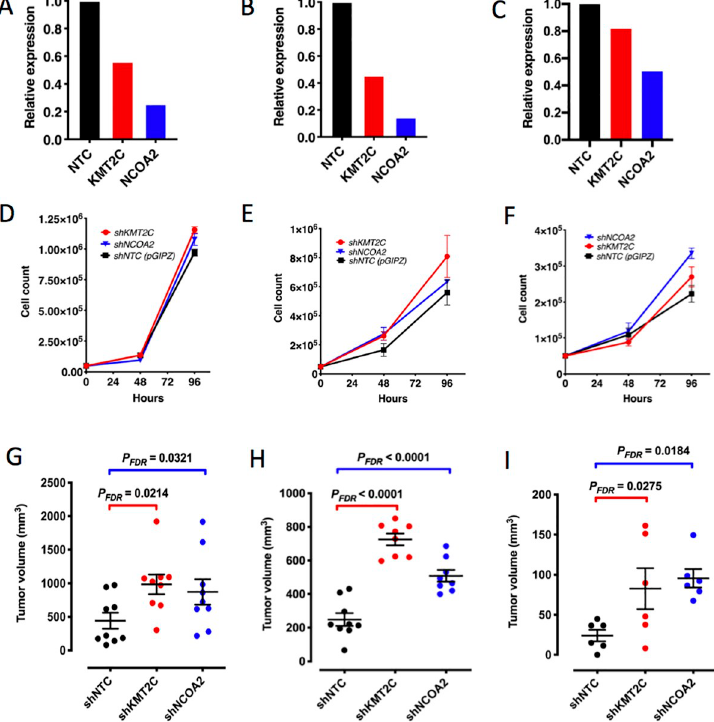
Fig 9. In vitro and in vivo functional validation of chromatin remodelers in cuSCC. Levels of shRNA-mediated knockdown of KMT2C or NCOA2 in human cuSCC cell lines ( A ) A431 ( B ) COLO16 or ( C ) SCC13 cells confirmed by qPCR compared to a non-targeting (NTC) shRNA. Target gene knockdown significantly increases proliferation rates of ( D ) A431 (shNTC vs. sh KMT2C q -value < 0.0001; shNTC vs. sh NCOA2 q -value = 0.0019; sh KMT2C vs. sh NCOA2 q = 0.017), ( E ) COLO16 (shNTC vs. sh KMT2C q -value = 0.01; shNTC vs. sh NCOA2 q-value = 0.4; shKMT2C vs. shNCOA2 q = 0.06) or ( F ) SCC13 cells (shNTC vs. shKMT2C q -value = 0.06; shNTC vs. shNCOA2 q -value < 0.0001; shKMT2C vs. shNCOA2 q = 0.01); 3 replicates per group; error bars, SEM; statistical significance measured by two- factor ANOVA followed by FDR-corrected q- values for multiple comparisons. KMT2C and NCOA2 knockdown significantly accelerates cuSCC xenograft progression in vivo . ( G ) A431, corrected P = 0.0488 (shNTC vs. sh KMT2C P FDR = 0.0214; shNTC vs. sh NCOA2 P FDR = 0.0321), ( H ) COLO16, corrected P < 0.0001 (shNTC vs. sh KMT2C P FDR < 0.0001; shNTC vs. sh NCOA2 P FDR < 0.0001) and ( i ) SCC13, corrected P = 0.0198 (shNTC vs. sh KMT2C P FDR < 0.0275; shNTC vs. sh NCOA2 P FDR = 0.0184). Statistical significance measured by one-way ANOVA followed by multiple pairwise comparisons and FDR-adjusted P- values.